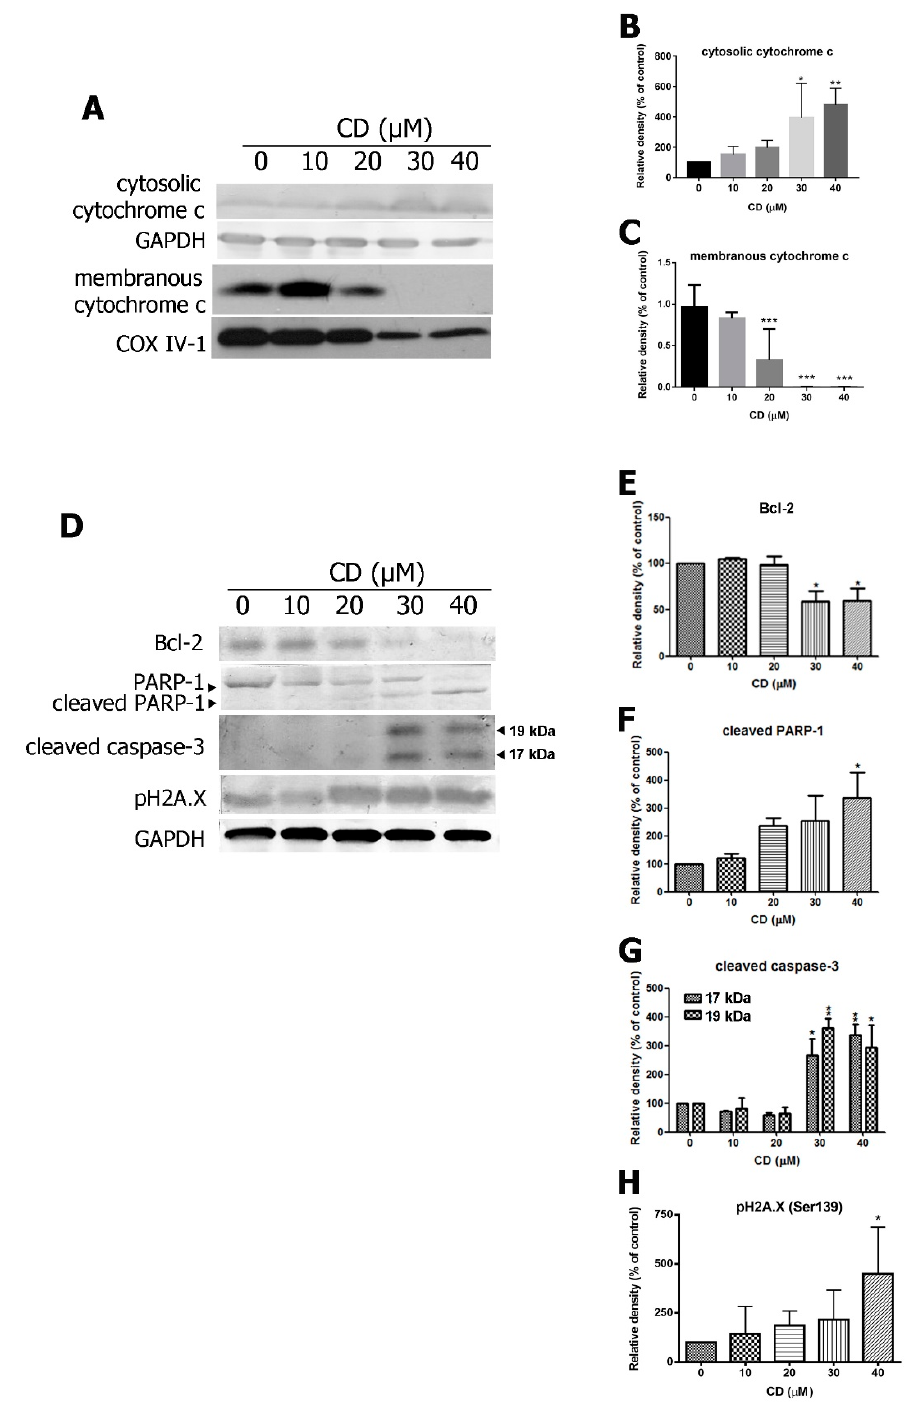
Figure 5. E ff ects of CD on pro-apoptotic and anti-apoptotic proteins in T24 BC cells. ( A ) The expression of cytochrome c in the cytosolic fraction and membrane fractions. Glyceraldehyde 3 phosphate dehydrogenase (GAPDH) and cytochrome oxidase subunit IV isoform 1 (COX IV-1) were used as internal controls. ( B , C ) Quantifications of protein expression. ( D ) The expression of Bcl-2, cleaved PARP-1, 17 kDa, and 19 kDa subunits of cleavage caspase-3 and pH2A.X. ( E – H ) Quantifications of the protein expression. Bar graphs show normalised values as percentages relative to the control. Data are expressed as mean ± SD of three to five independent experiments. * p < 0.05, ** p < 0.01, *** p < 0.001 compared with the control group (0 µM).